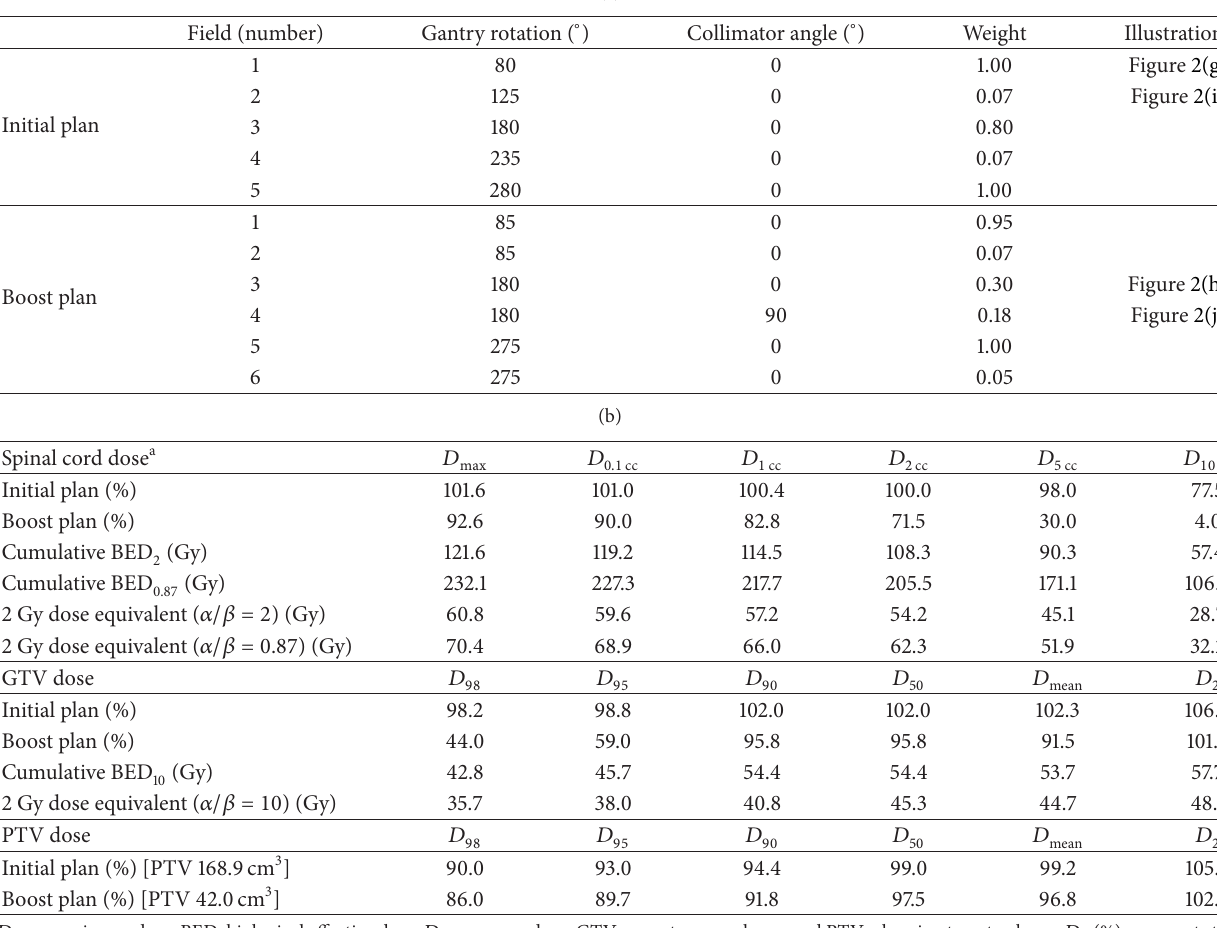
Table 1: Beam arrangement (a) and dose-volume histogram data